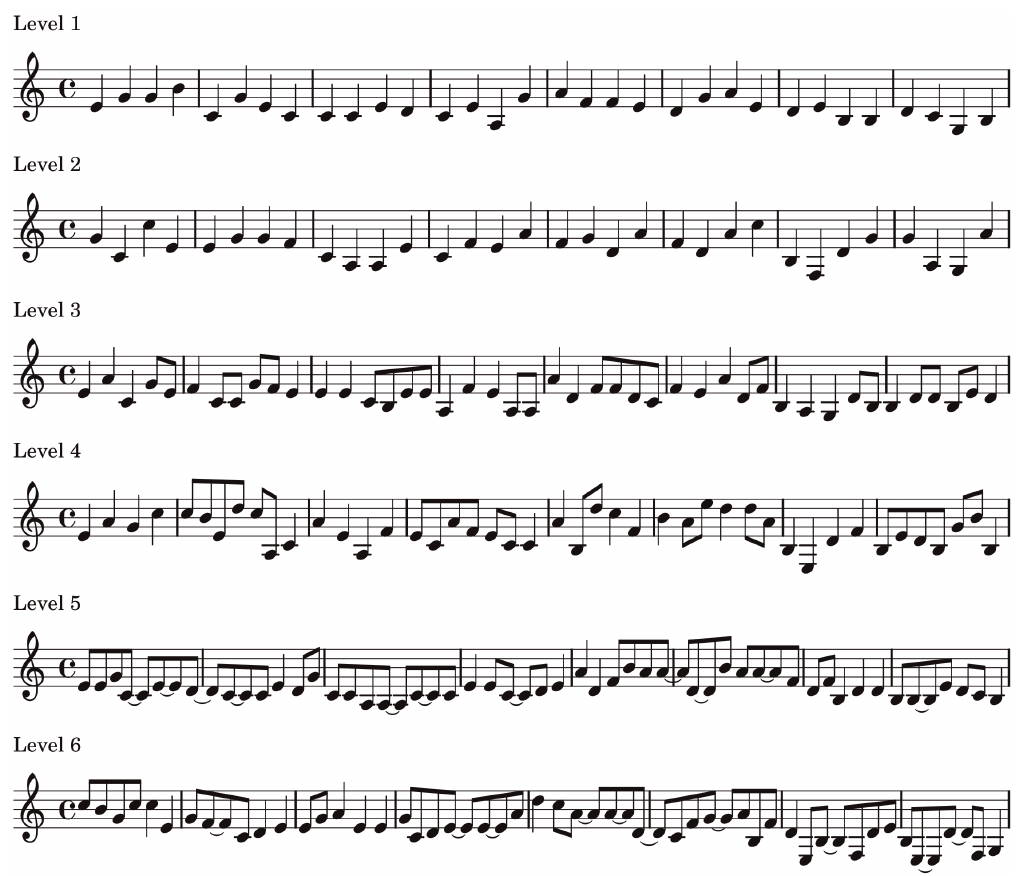
Figure 1. A musical score to illustrate the different levels of complexity for the melody lines of our stimuli. The musical sequences all modulate through two bars of C major, A minor, D minor and G7 major, respectively.